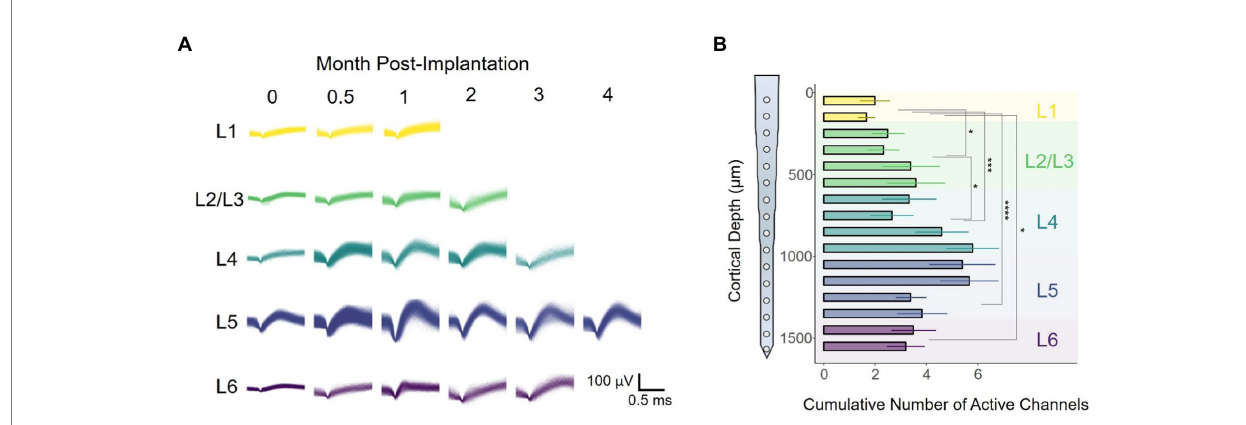
FIGURE 3 Electrode-sites on layer 4 and 5 remain more active over time. (A) Representative spike waveforms of one rat as a function of time. (B) Channels in which spikes units were present were deemed as active. Bar chart plot of the average number of active channels per site across the duration of the study. Active channels were binned in cortical layers for quantification (one-way ANOVA followed by Dunn–Bonferroni’s correction). * p ≤ 0.05, ** p ≤ 0.01, *** p ≤ 0.001, **** p ≤ 0.0001. Error bars indicate mean ±